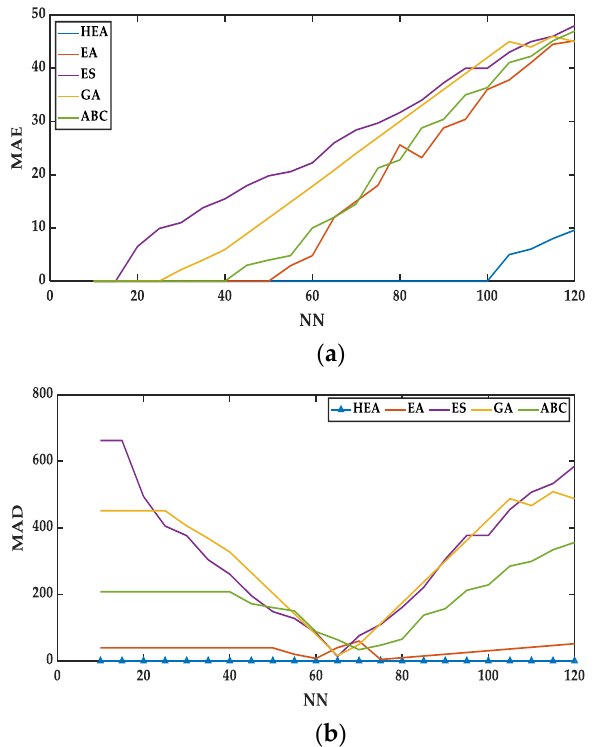
Figure 5. ( a ) MAE-Fitness value for different DHNN-RAN k SAT models. ( b ) MAD-Fitness value Figure 5. ( a ) MAE -Fitness value for different DHNN-RAN k SAT models. ( b ) MAD -Fitness value for for different DHNN-RAN k SAT models. different DHNN-RAN k SAT Table 5. Tabulated fitness values for different DHNN-RAN k SAT models.